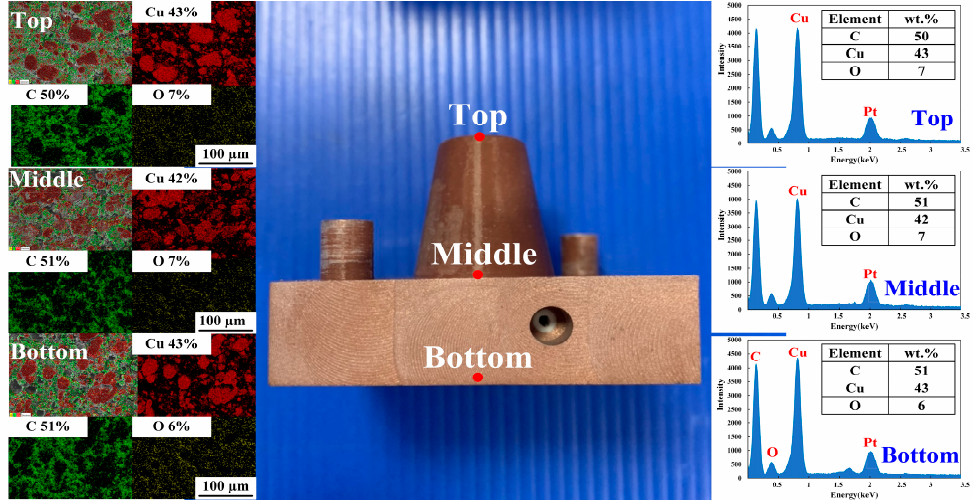
Figure 21. Precipitation analysis of the core insert fabricated by epoxy resin added with Cu powder.